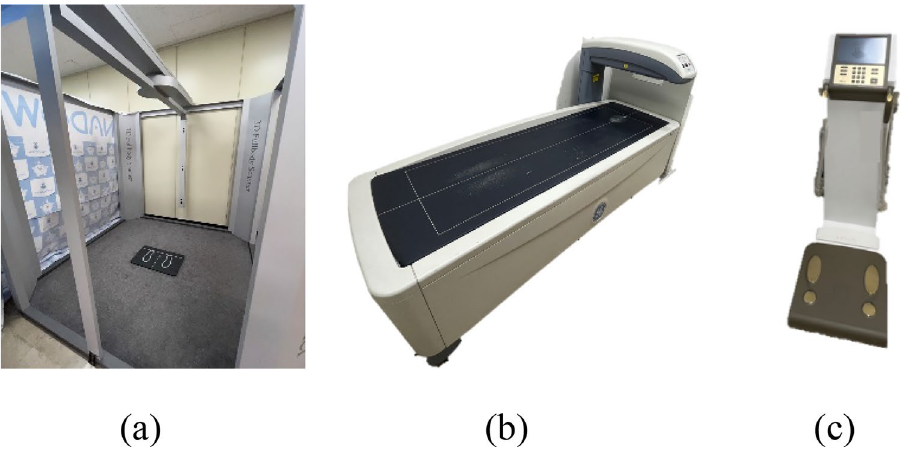
Figure 2. Equipment used in the experiment. ( a ) 3D scanner (PFS-304 of PMT), ( b ) DXA (Lunar of GE), ( c ) BIA